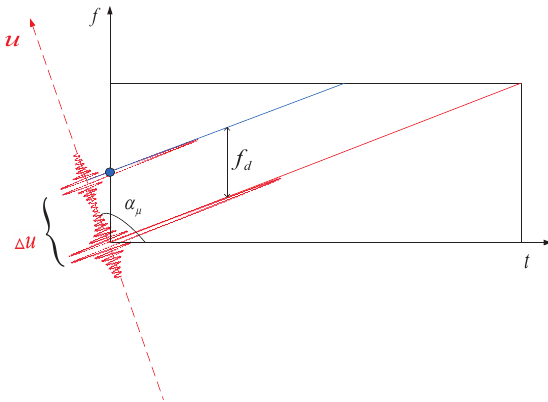
Figure 3. Rotation angle